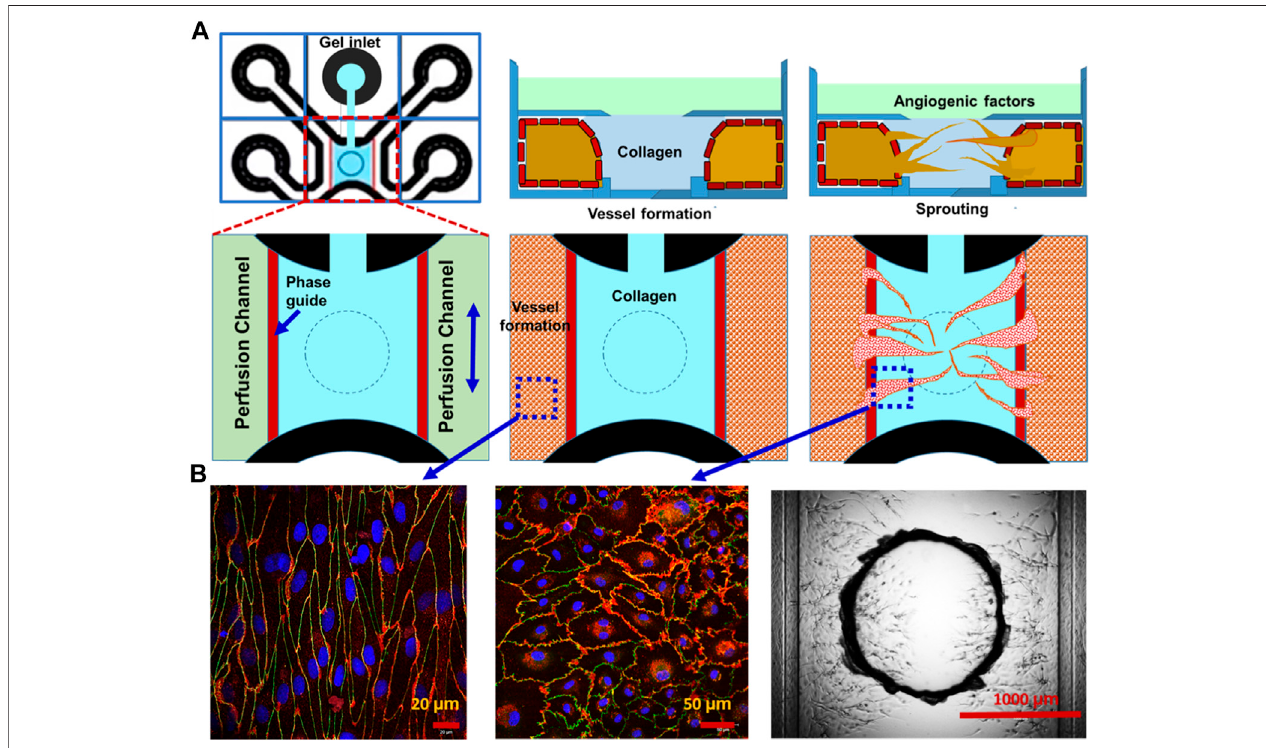
FIGURE 6 | Vascularization of brain-like tissue model using micro fl uidics-based microchannels. Potential vascularization strategy of human brain-like tissue: (A) schematic representation of different phases of vascularized tissue culture using the OrganoPlate Graft. (B) Staining (CD31: red and ZO-1: green) and DIC images of vascularized